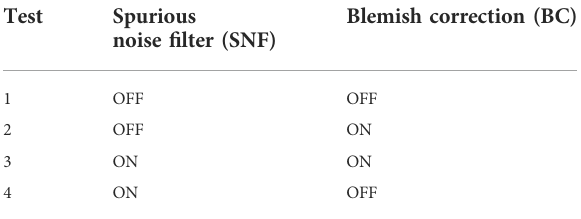
TABLE 1 Summary in the division of the data of the camera for the analysis.